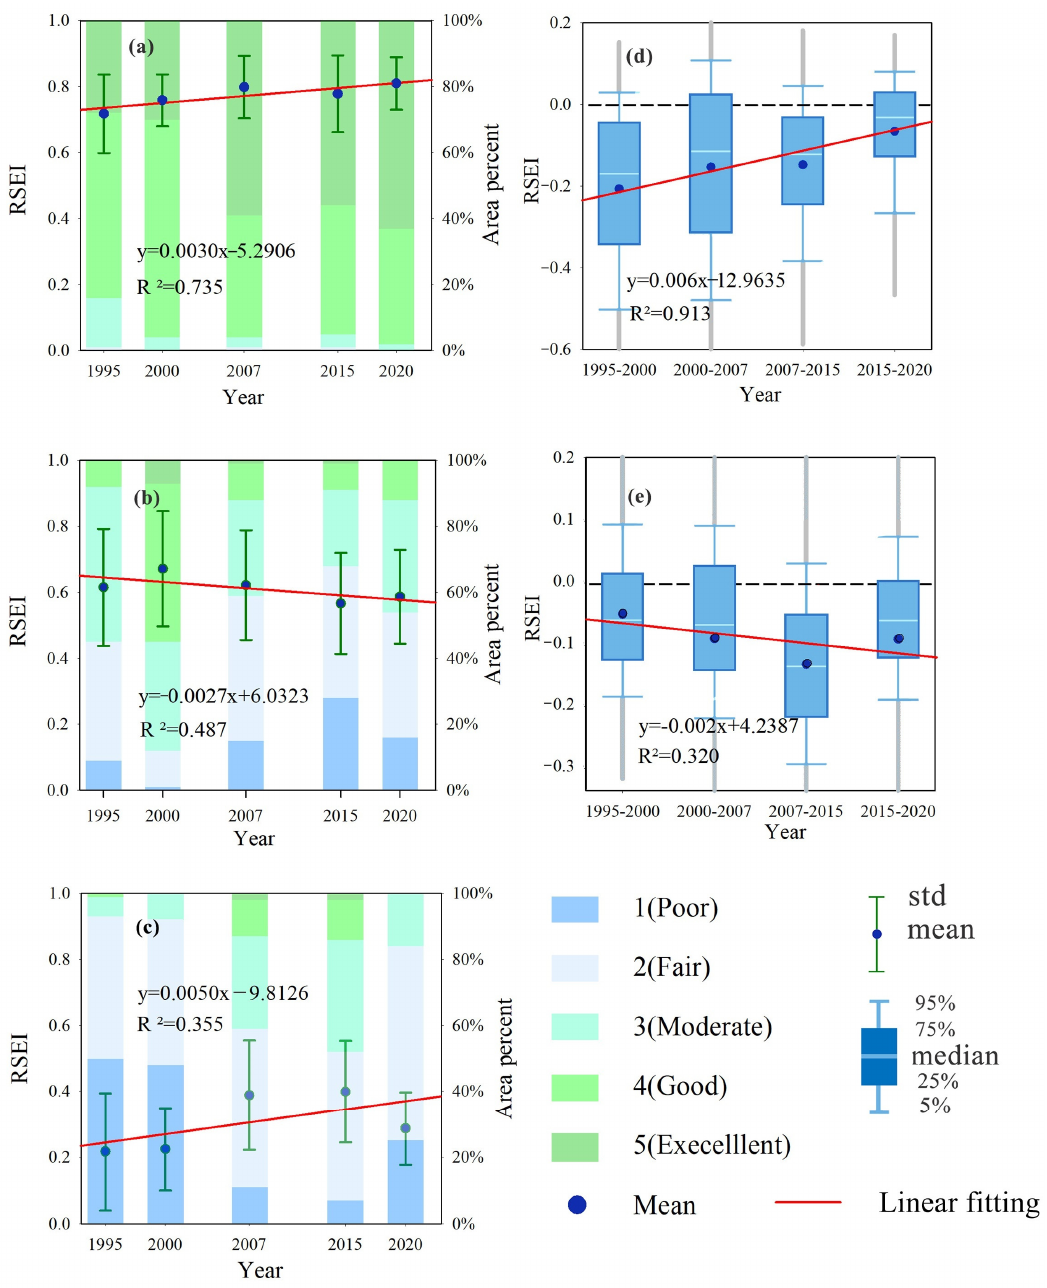
Figure 9. Ecological quality changes for different land use types and their conversions during 1995– 2020: ( a – c ) changes in the RSEI for forest, farmland, and build-up without conversions; ( d , e ) Changes in the RSEI difference for the conversions from farmland to built-up areas and from